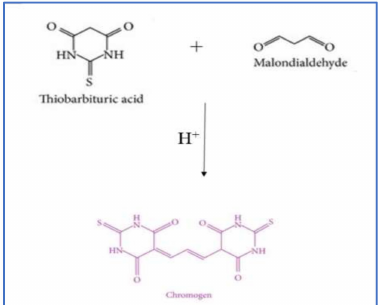
Figure 2. Formation of chromophore during the TBARS